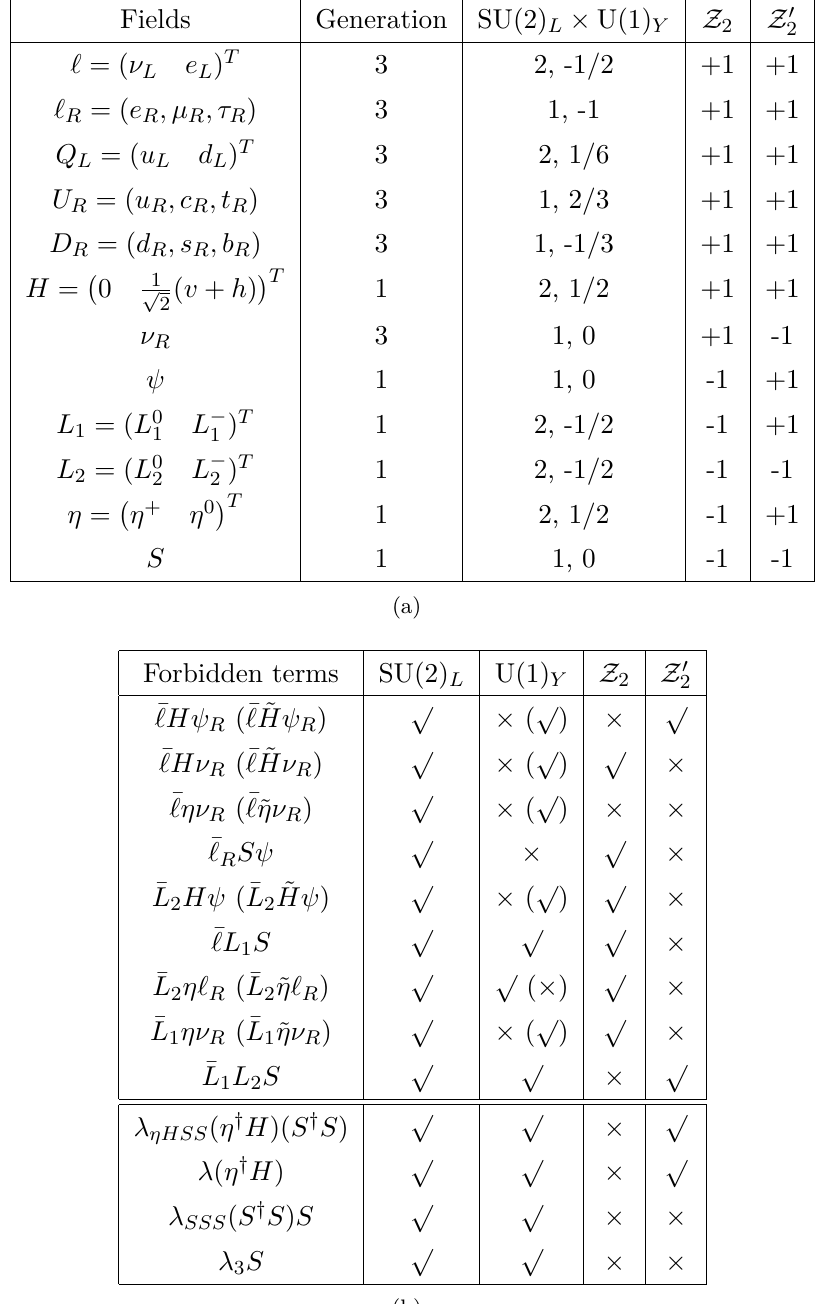
Table 1 . (a) Particles and their transformations under SU(2) L × U(1) Y × Z 2 × Z 0 interaction terms and their transformations under different gauge and discrete